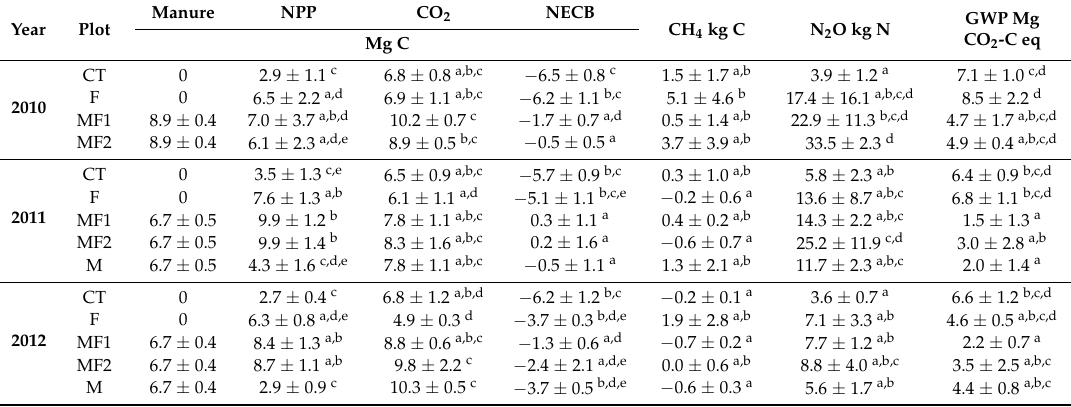
Table 2. Annual manure C input, net primary production (NPP), CO 2 emission, net